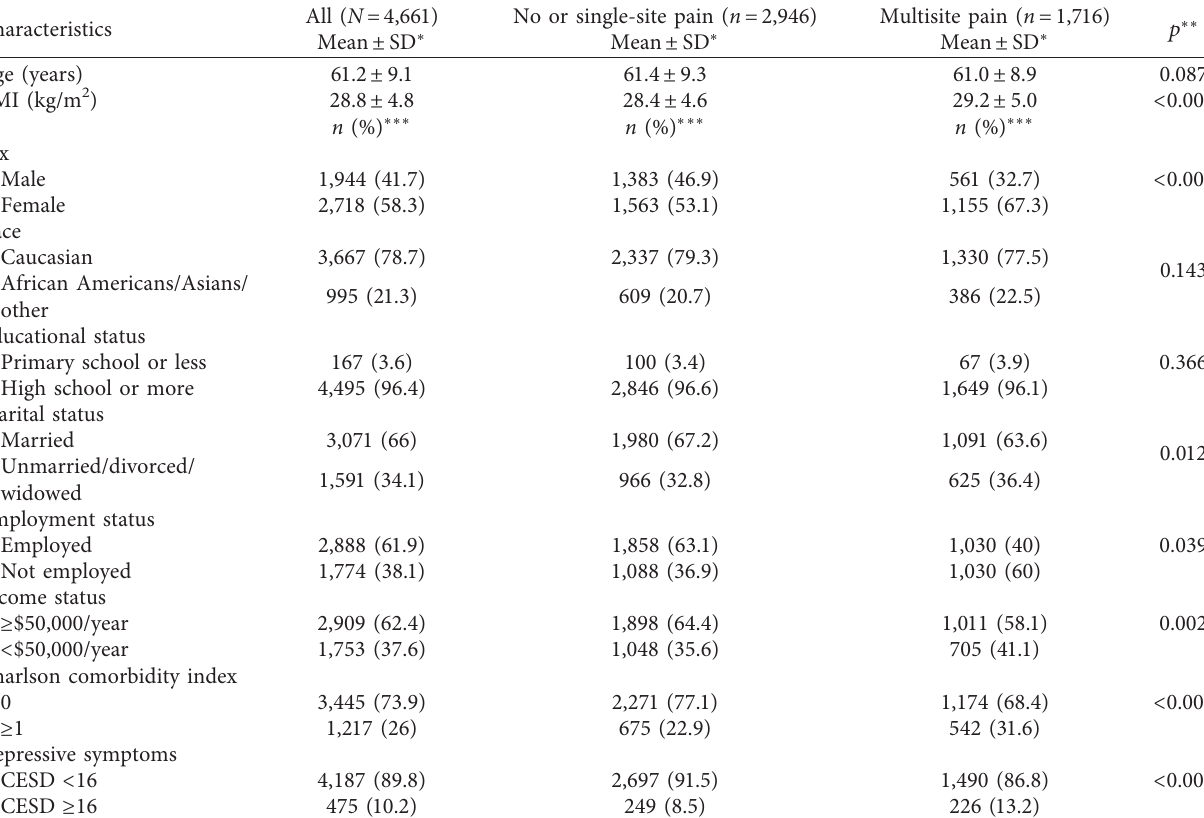
Table 2: The demographic characteristics of the study participants with the presence or absence of pain in the lower limbs.